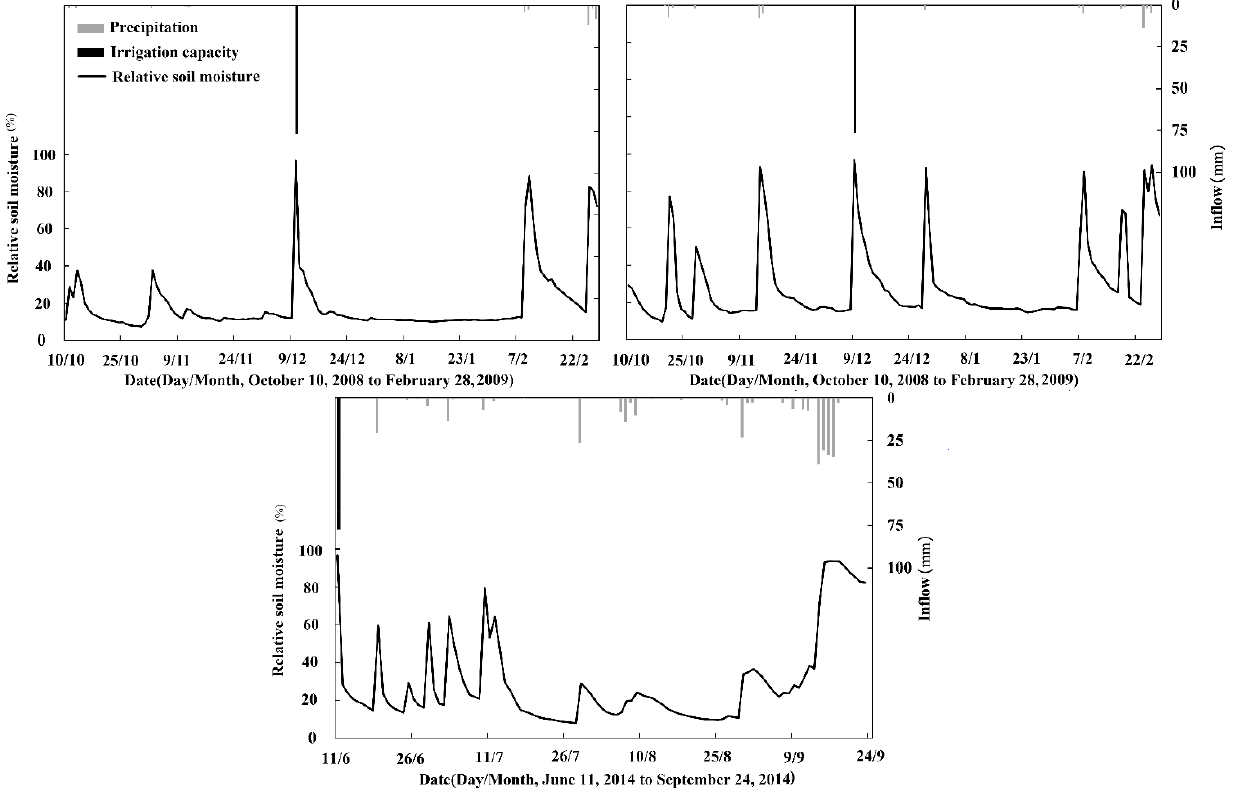
Figure 4. Variation of the daily relative soil moisture during typical drought events in the experimental area.